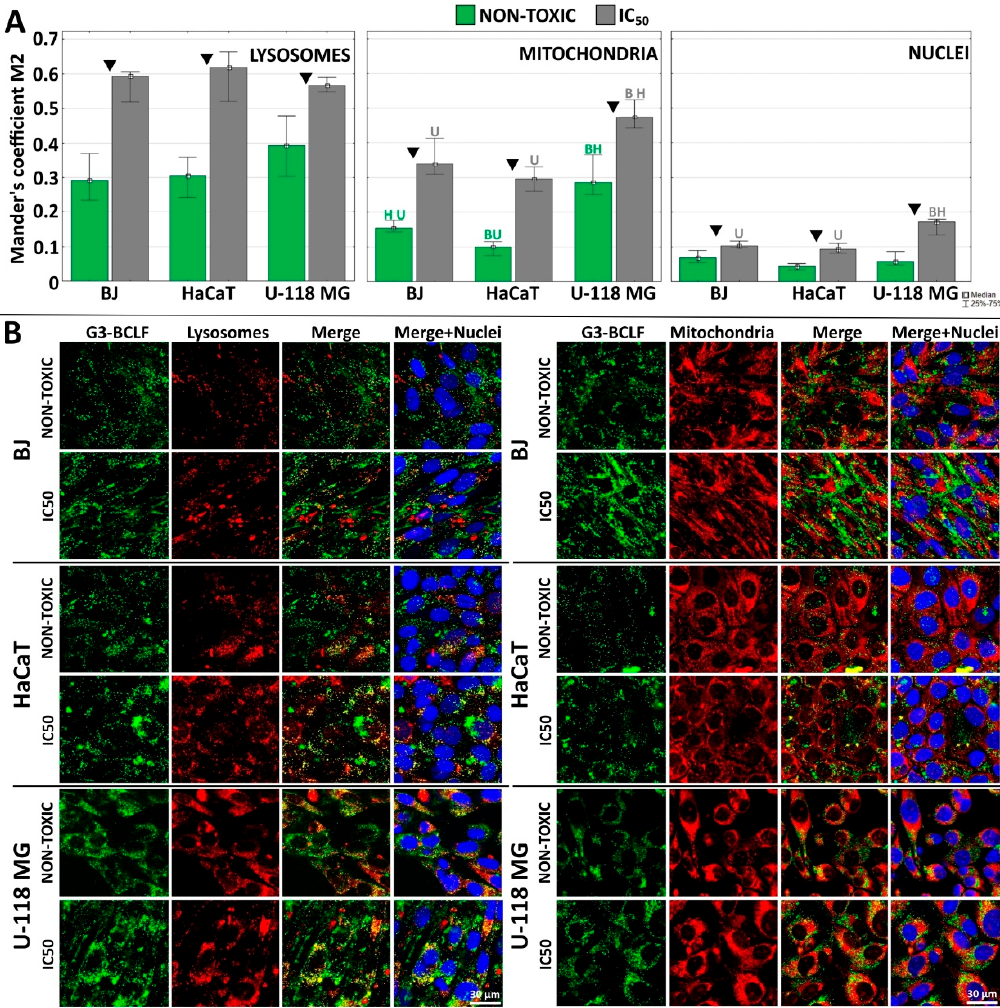
Figure 4. A ) Localization of G3-BCLF in lysosomes, mitochondria and nuclei of BJ, HaCaT and U-118 MG cells after 24 h incubation at low, non-toxic (0.1 µM) and equal to IC 50 concentrations. Results are medians of twelve images measurement from each experimental group and expressed as Mander’s coefficient. The whiskers are lower (25%) and upper (75%) quartile ranges. Letters indicate significant differences between cell lines (each letter indicate cell line), P < 0.05; Kruskal-Wallis test. ▼ P < 0.05; Mann–Whitney U-test (non-toxic against IC 50 concentration). B ) Confocal images presenting colocalization of G3-BCLF within lysosomes, mitochondria and nuclei in investigated cell lines. Green signal: G3-BCLF, red: lysosomes (left panel) or mitochondria (right panel), blue: DAPI stained nuclei, yellow: overlapping signal from G3-BCLF and lysosomes or mitochondria. Scale bar equal 30 µm.